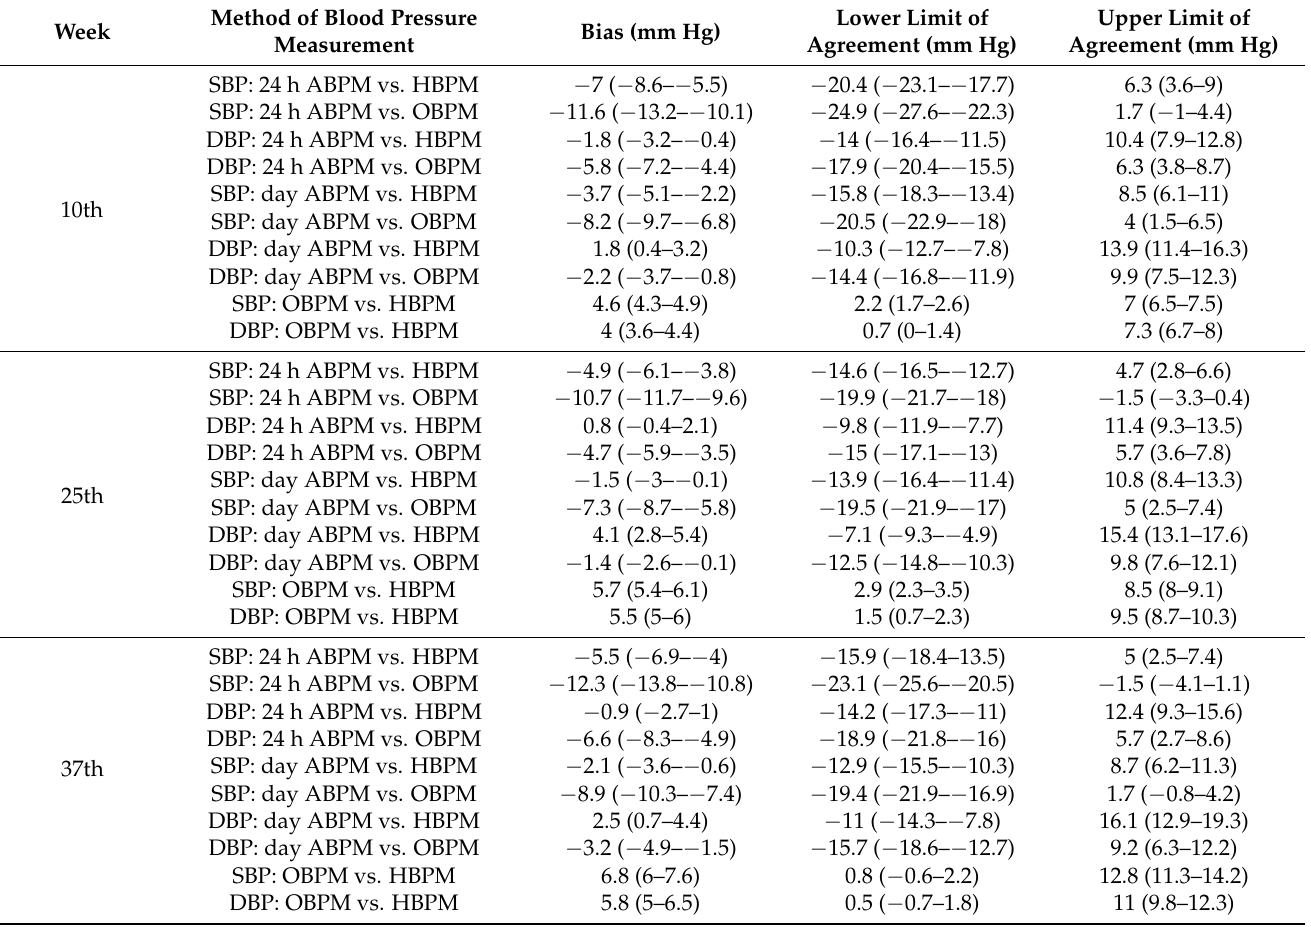
Table 3. The agreement between ABPM, HBPM, and OBPM measurements of blood pressure in 10th, 25th, and 37th week of pregnancy assessed using Bland–Altman